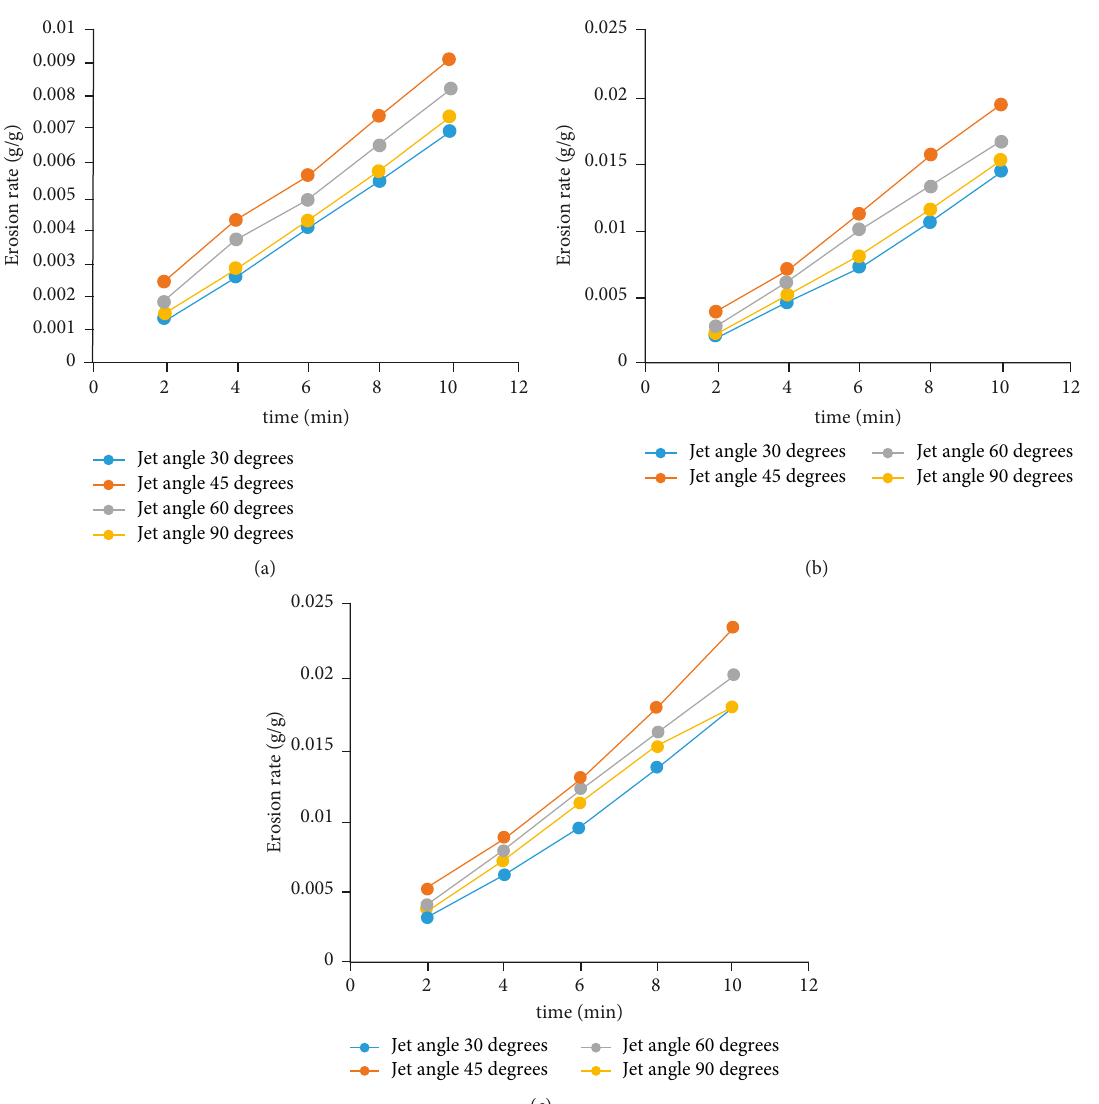
Figure 3. The results of the prepared samples air jet erosion test are presented below.